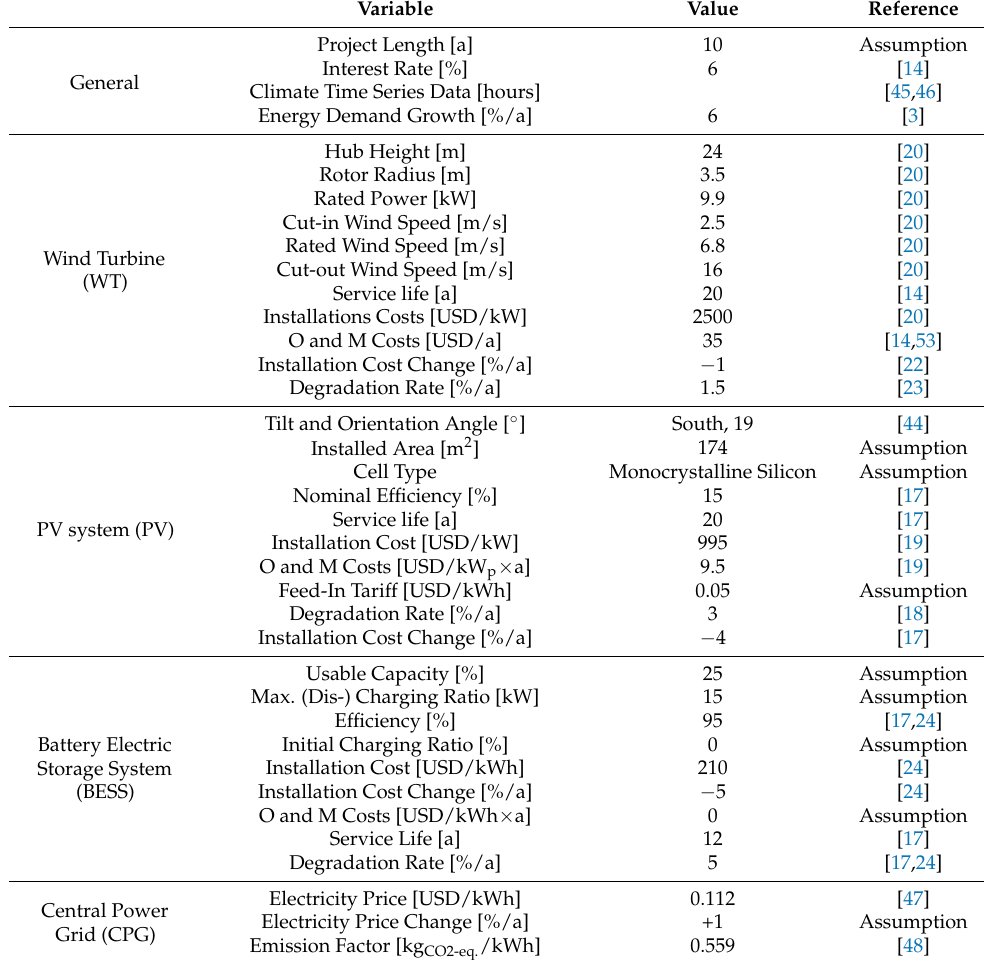
Figure A6. Hourly diffuse solar radiation in the year 2019 at the model community based on data from [45]. Appendix III. Input Data for NESSI4D. Table A1. Summary of input data for NESSI4D used for the